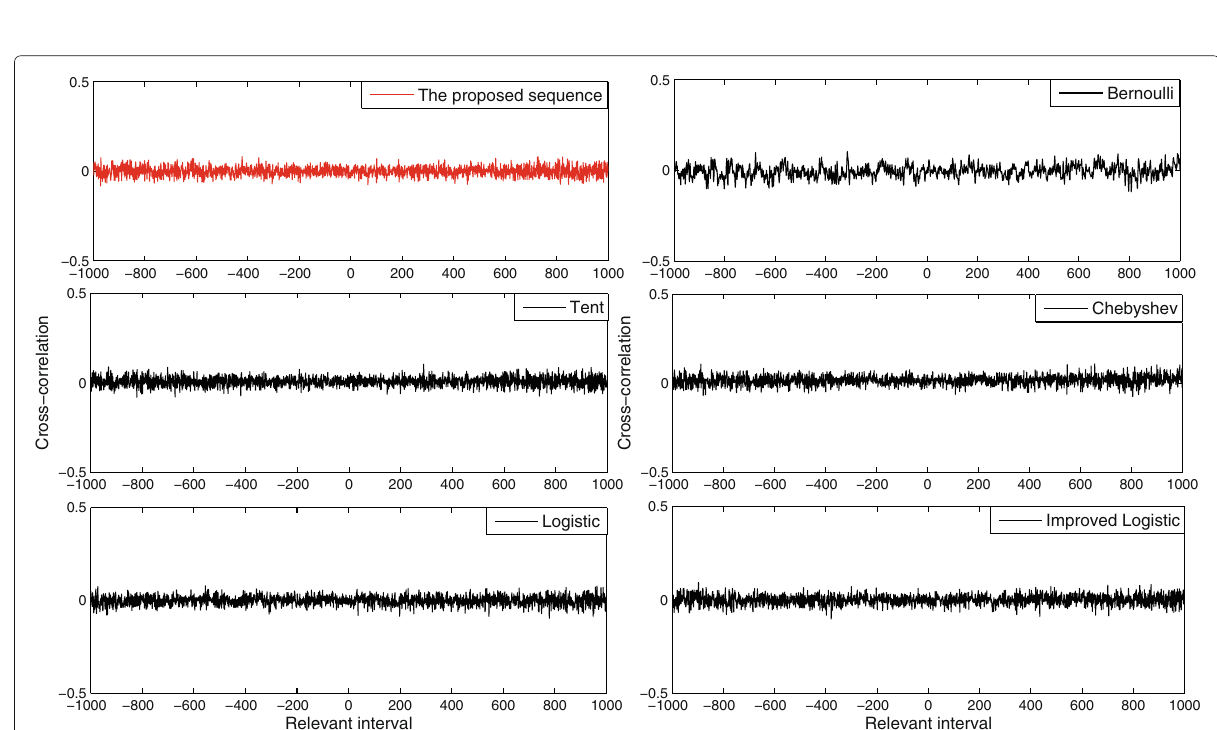
Fig. 4 Cross-correlation function of six chaotic